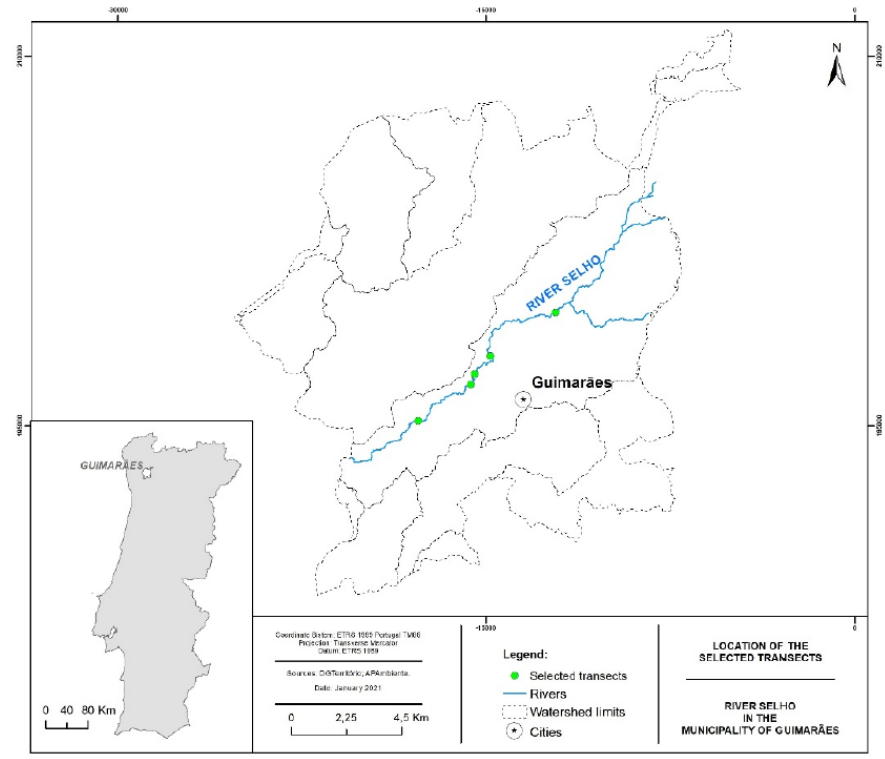
Figure 1. Location of River Selho in the Guimar ã es Municipality and selected transects for RHS